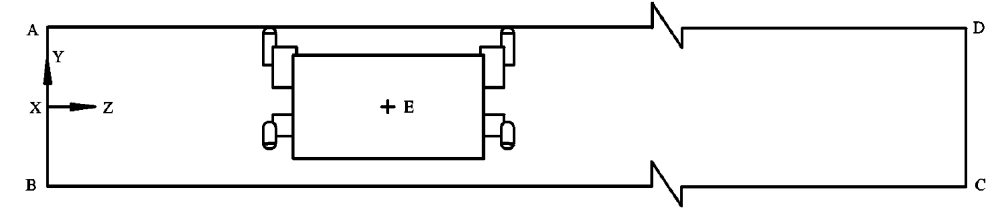
Water 2020 , 12 , x FOR PEER REVIEW Figure 1. Mathematical model of capsule transport in a straight pipe. Figure 1. Mathematical model of capsule transport in a straight pipe.